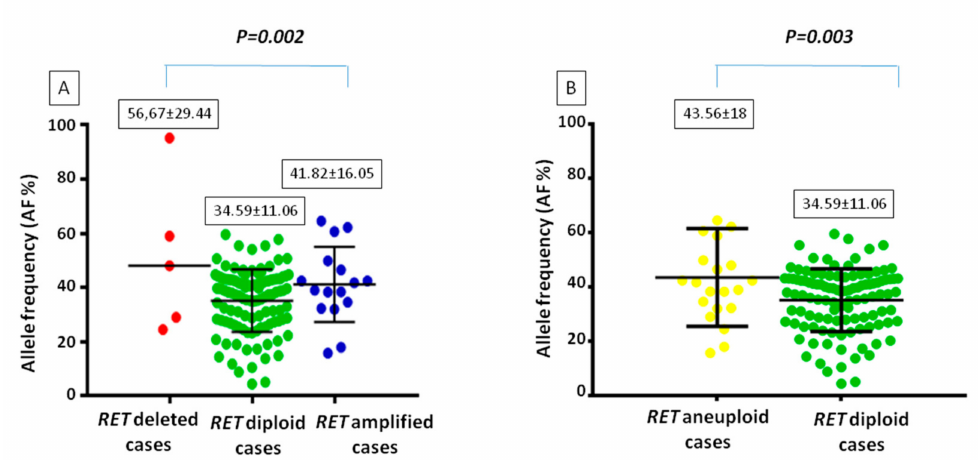
Figure 5. Comparison between the allelic frequency of RET somatic mutation and the status of RET ploidy. ( A ) amplified and deleted cases are considered separately; ( B ) RET deleted and amplified cases (i.e., aneuploid cases) have been considered as a single